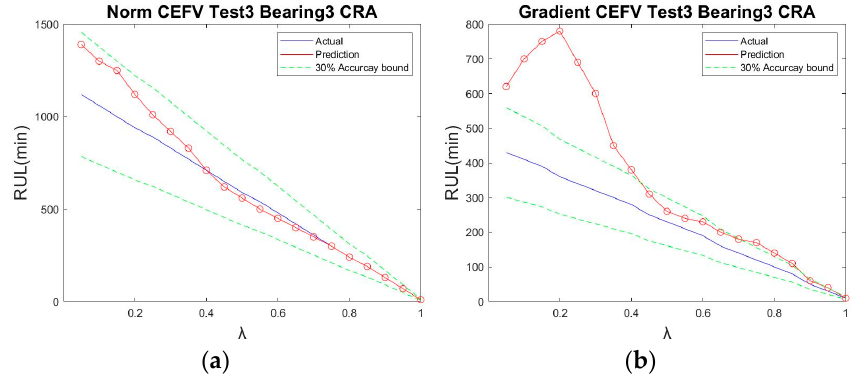
Figure 13. CRA of IMS Test 3 Bearing 3: ( a ) using the norm tracking value; ( b ) using the gradient tracking value.